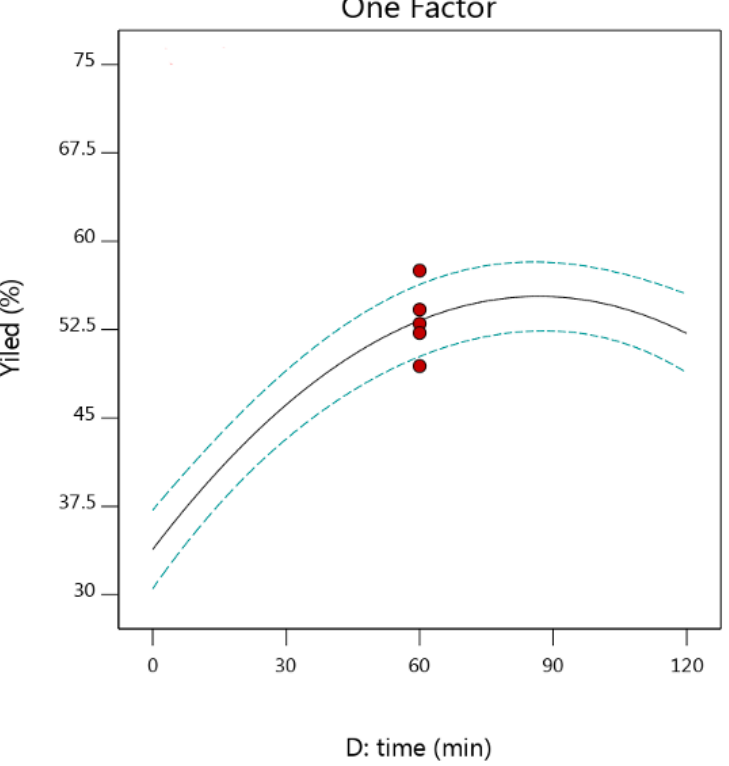
Figure 11. The effect of reaction time on the yield of 1,2-epoxy-5-hexene.